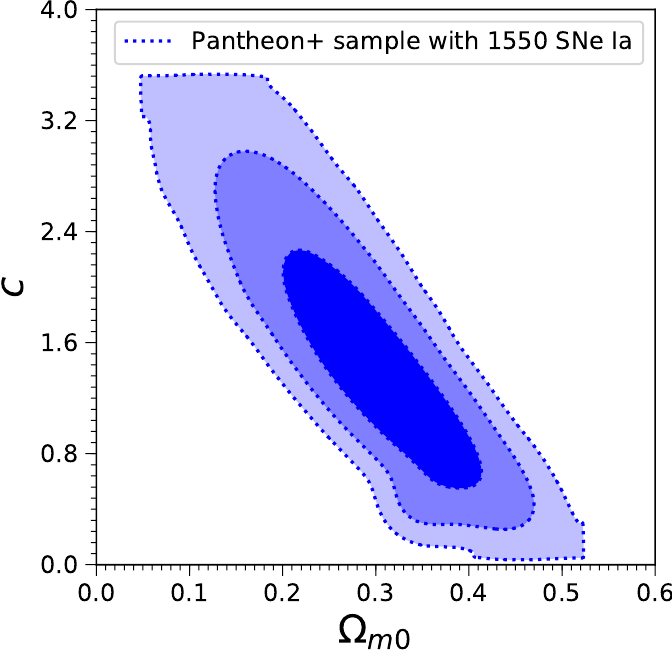
Figure 9. Confidence intervals at 68% ,95% and 99% in the ( Ω m0 , c ) plane constrained from the Pantheon+ SNe Ia sample including 1701 light curves of 1550 distinct SNe Ia with 0.001 < z <